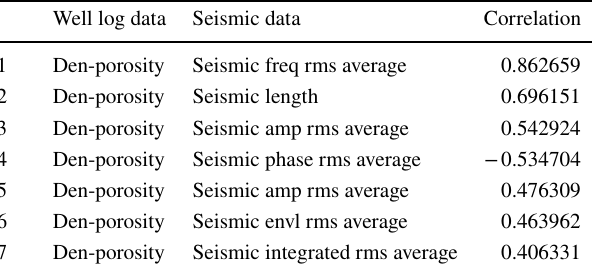
Table 10 Evaluation of different attributes in the second category